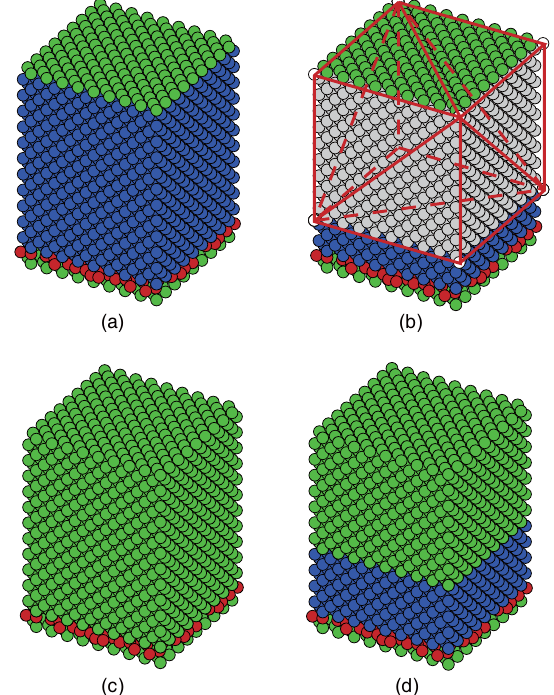
Fig. 1 Schematic diagram of 3D mono-layer molecular thin-film lubrication system with periodic boundary conditions in the x and y directions. The wall, the elastic/rigid substrate, and the fluid atoms are represented by the green, blue/green, and red spheres, respectively. (a) Fully atomistic description, (b) partial coarse graining of the far region of the substrate, (c) wholly rigid substrate/0-layer near the region or the crystalline model, and (d) rigid far region/8-layer near region. The coarse-grained far region of the substrate is represented by the gray spheres. All atoms are depicted in their initial configuration at  0